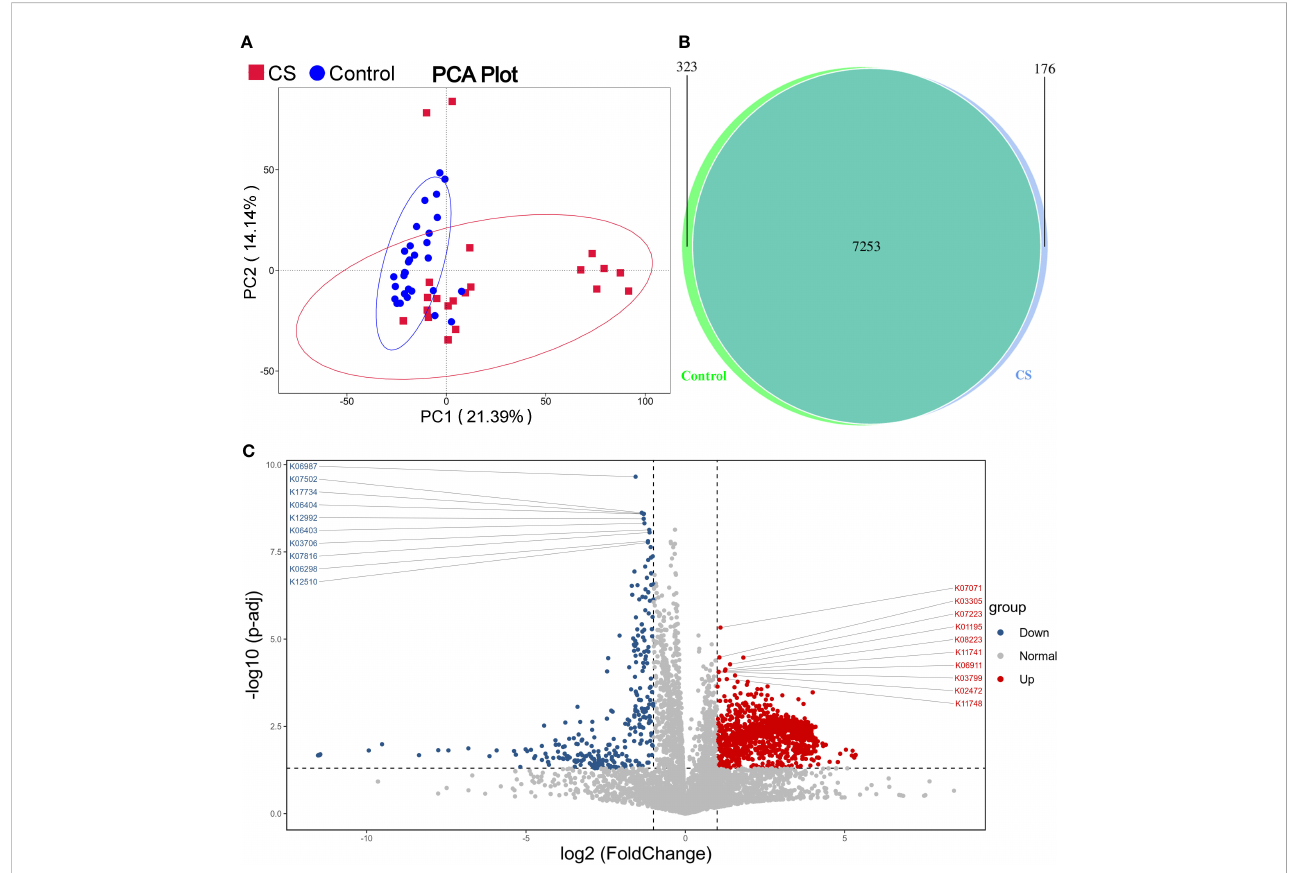
FIGURE 4 Function prediction analysis. (A) : PCA analysis revealed that the bacterial gene of the CS group might be different from the control group. (B) : Venn graph showing the number of genes in the two groups. (C) : Volcano map of differential genes. CS, Cushing's syndrome; PCA, Principal Component